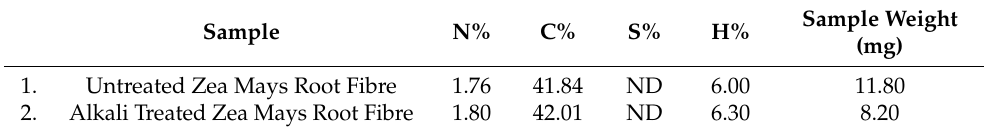
Table 8. CHNS analysis of untreated and alkali treated Zm fibres.